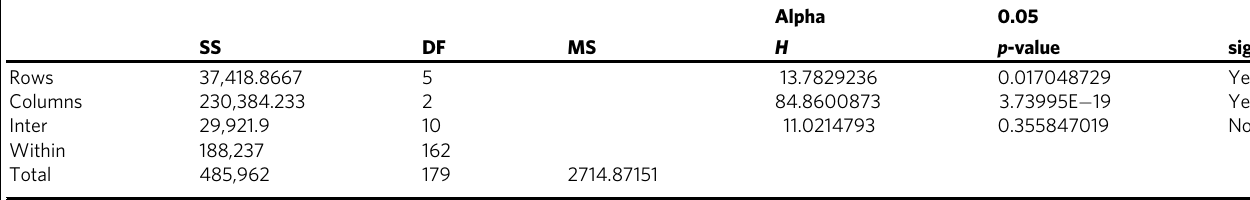
Table 4 Scheirer ray hare test